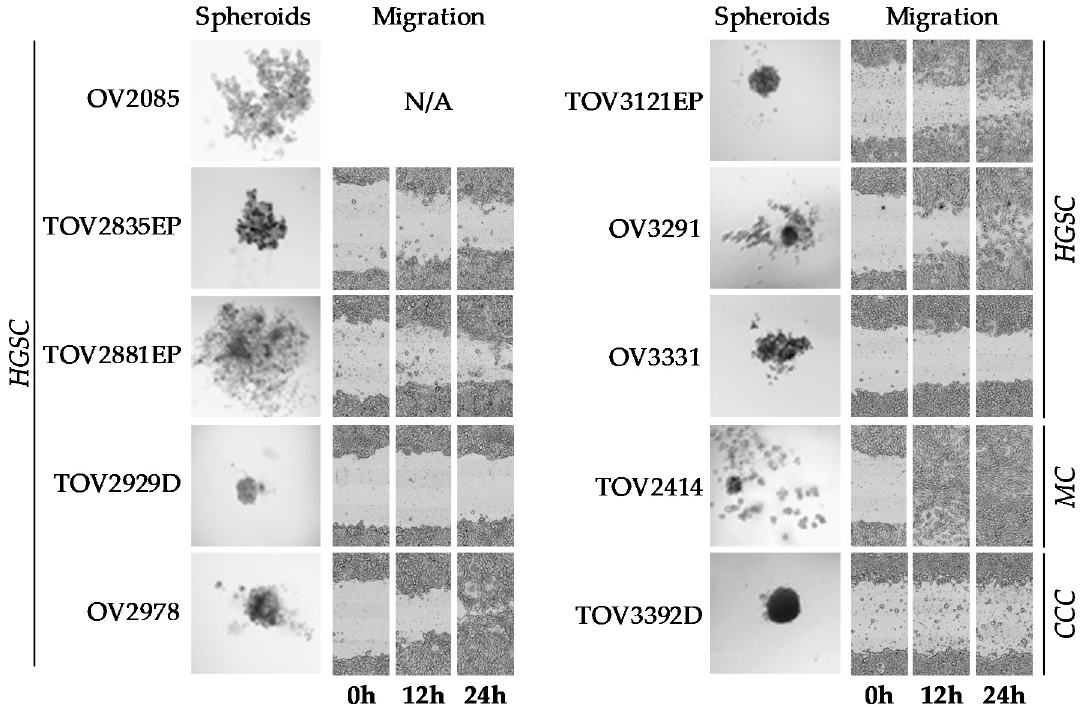
Figure 6. In vitro culture phenotypes. Spheroid formation of cell lines after 5–8 days using the hanging droplet technique with 2000 cells seeded, and migration evaluated by wound-healing scratch assay. Photos for migration were taken 0, 12, and 24 h after the plate was scratched. All photos are representative of three independent experiments.